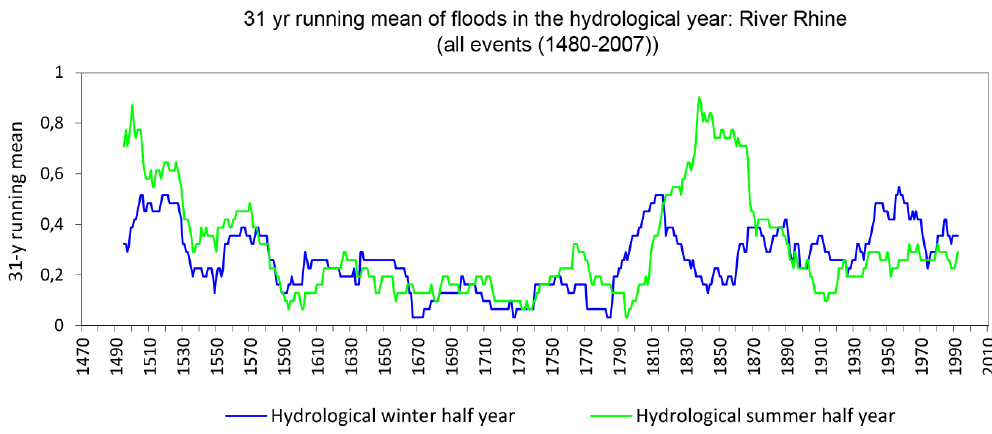
Figure 8. Floods of the River Rhine in the hydrological summer and winter years (all